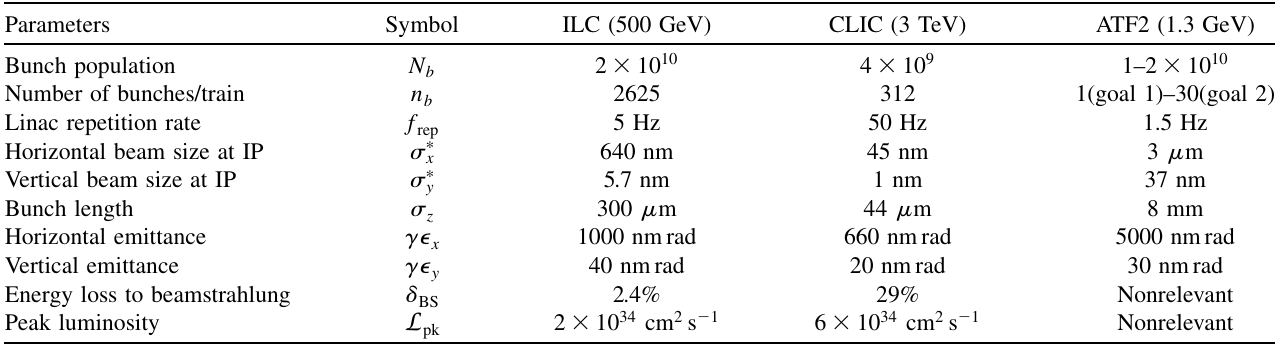
TABLE I. Comparison of the parameters of ILC, CLIC, and